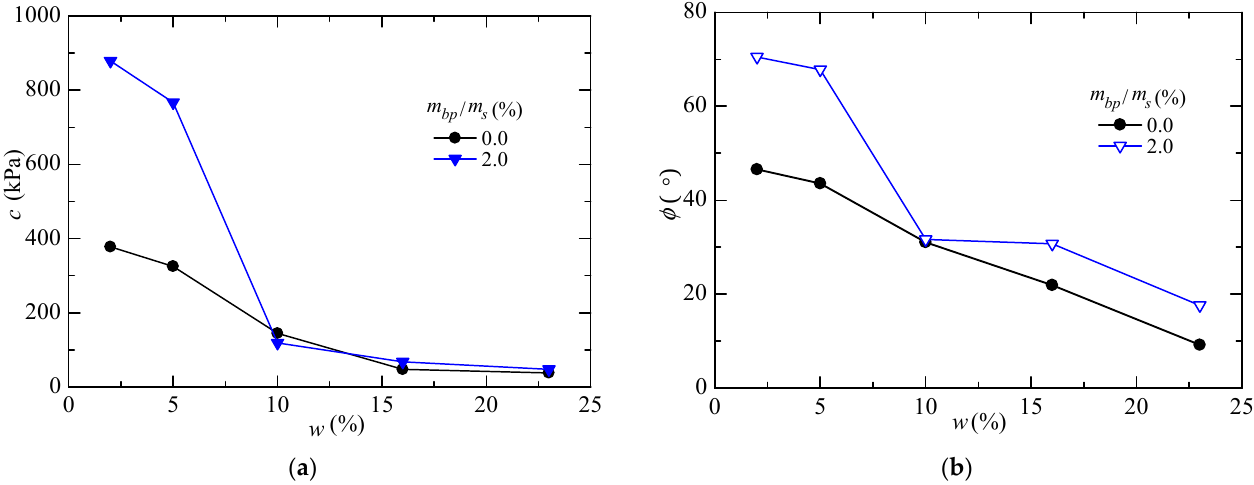
Figure 18. Comparison of shear strength parameters before and after treatment: ( a ) w-c relation curve; ( b ) w- ϕ relation curve.